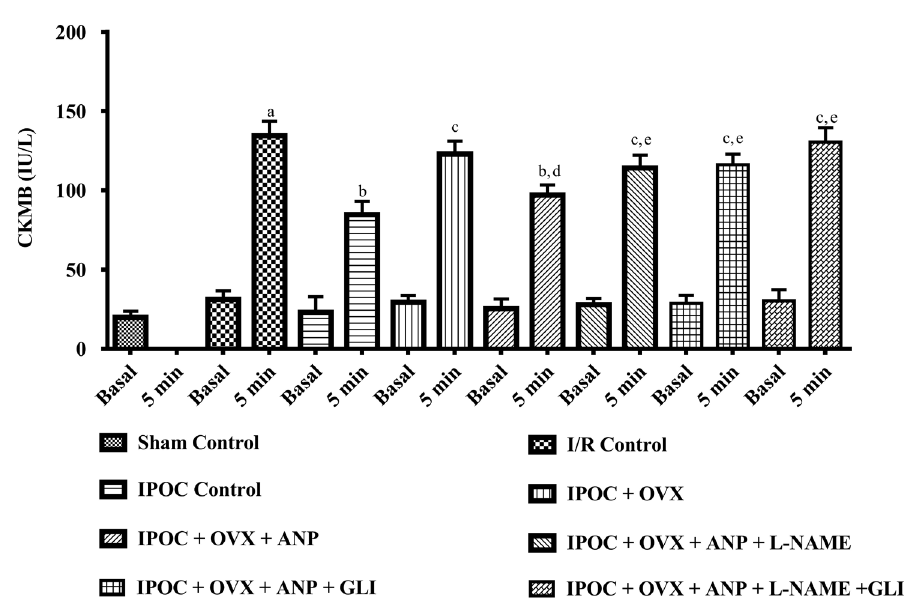
FIGURE 10 - Effect of I/R on release of nitrite, effect of IPTC on release of nitrite in normal and OVX rat heart, effect of ANP perfusion, effect of L-NAME and ANP perfusion, effect of Glibenclamide and ANP perfusion and effect of